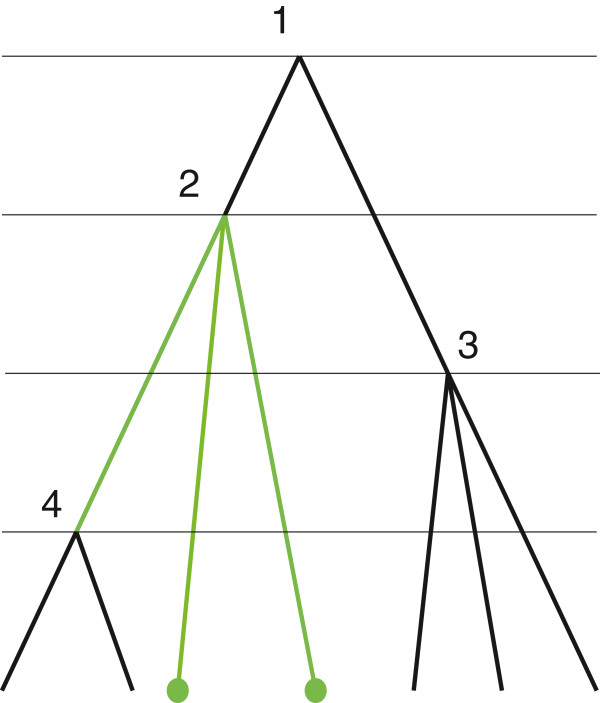
Constraint tree. Constraint tree, labels are omitted. Subtree 2 is coloured green. It has two child nodes that are leaves, therefore, n2=2. The ancestor function for this tree is defined as f(2)=f(3)=1 and f(4)=2. A compact notation for this constraint tree is (n1,…,nk,f)=(0,2,3,2,{(2,1),(3,1),(4,2)}).